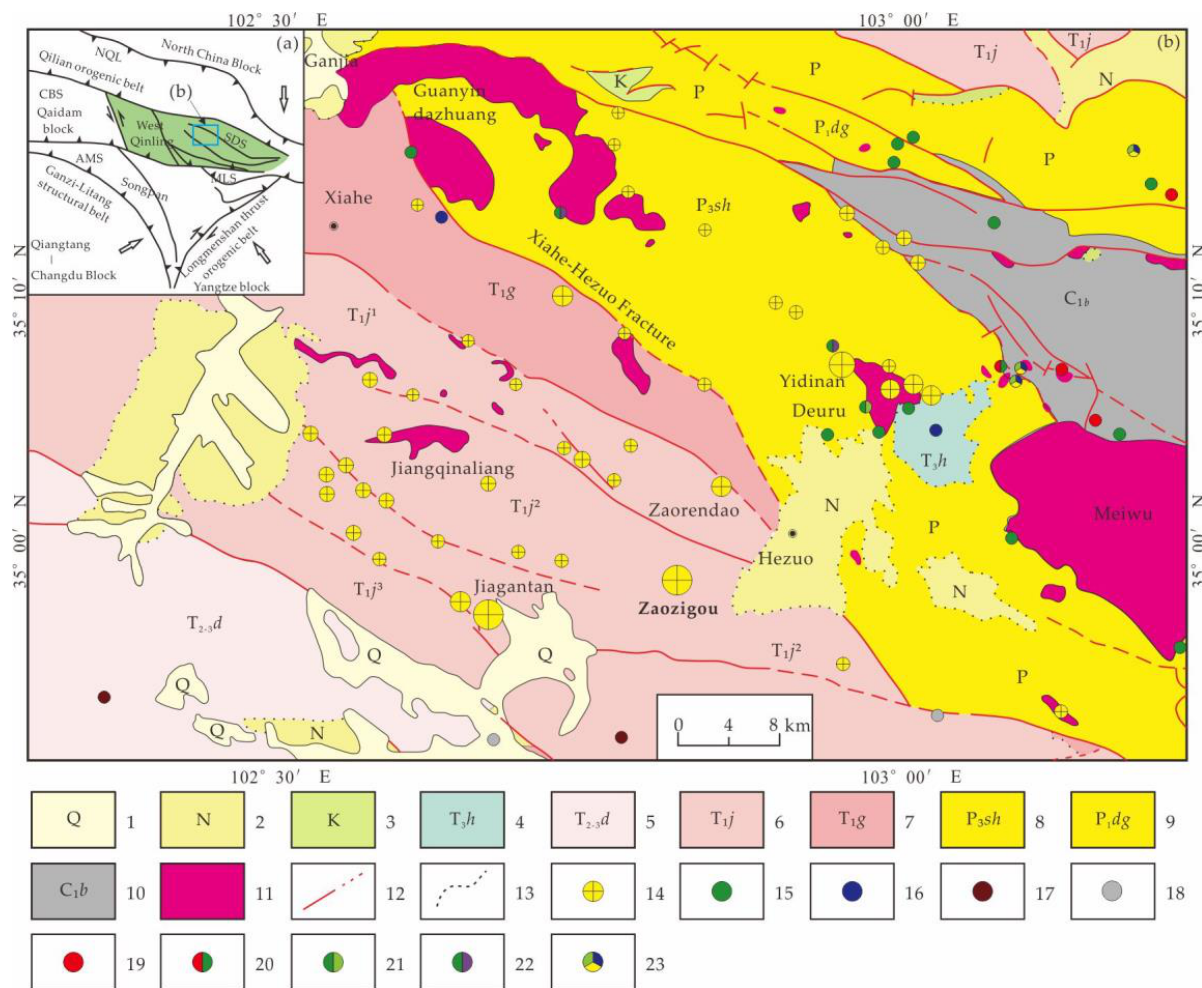
Figure 1. ( a ) Geotectonic location of the study area. NQL: North Qinling tectonic belt; SDS: Shangdan suture zone; CBS: Caibei suture zone; AMS: A’nyemaqen suture zone. ( b ) Geological map of Xiahe-Hezuo area (modified from [62]). 1. Quaternary; 2. Neogene; 3. Cretaceous;4. Upper Triassic Huari group; 5. Middle-Lower Triassic Daheba group; 6. Lower Triassic Jiangligou group; 7. Lower Triassic Guomugou group; 8. Upper Permian Shiguan group; 9. Lower Permian Daguanshan group; 10. Upper Carboniferous Badu group; 11. Intermediate-acid intrusive rocks; 12. Fracture; 13. Angular unconformity; 14. Gold depsit; 15. Copper deposit; 16. Lead depsit; 17. Antimony deposit; 18. Mercury deposit; 19. Iron deposit; 20. Iron – copper deposit; 21. Copper – molybdenum deposit; 22. Copper-tungsten deposit; 23. Polymetallic deposit.